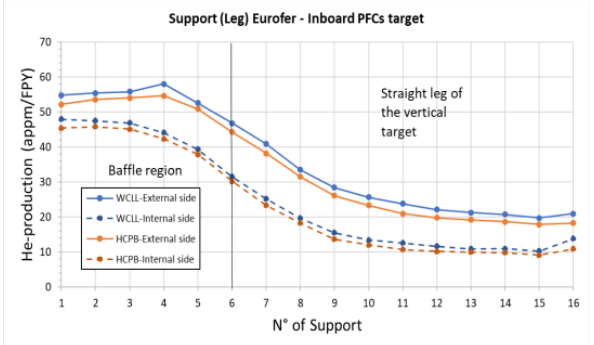
Figure 48. Inner poloidal profiles of the He-production (appm/FPY) on PFC-CB supports made of Eurofer, comparing the values on the external and the innermost target sides, both for WCLL and HCPB blanket case.